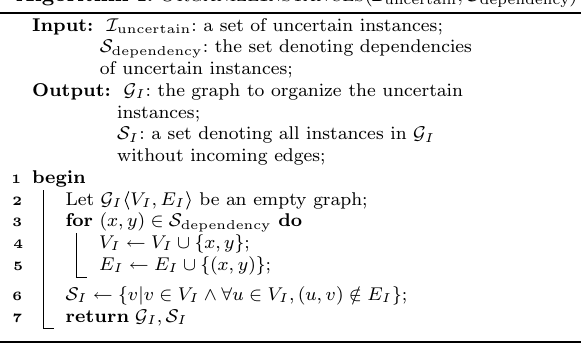
Algorithm 4: OrganizeInstances (